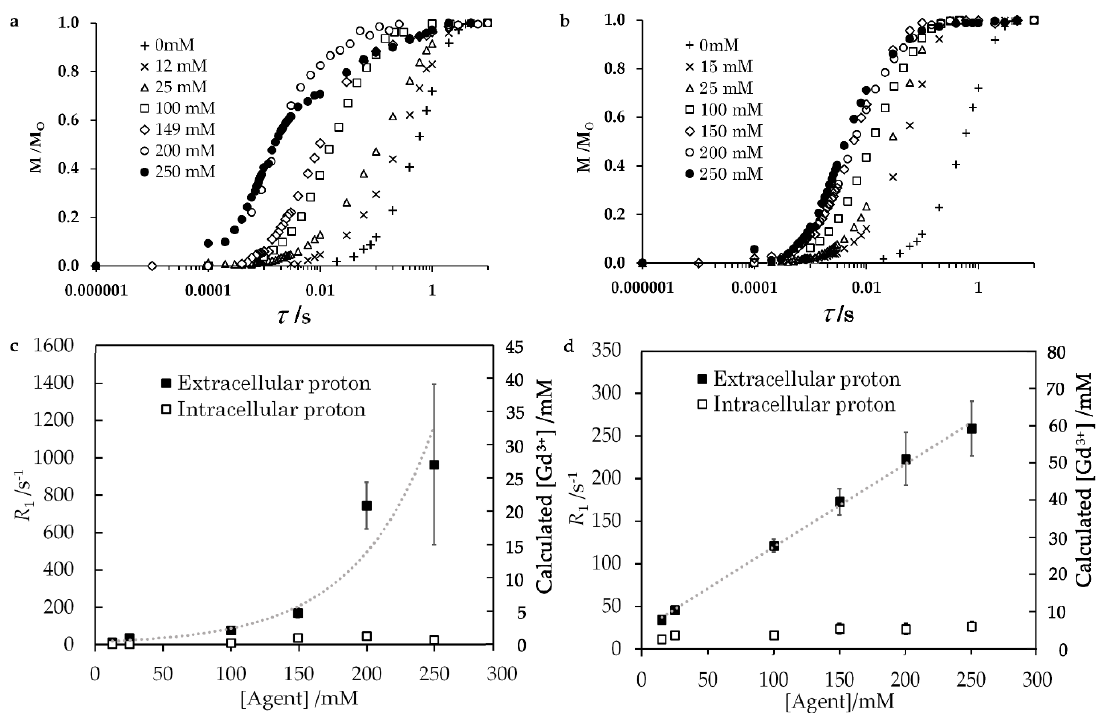
Figure 2. ( a , b ) Relaxation curves of the proton polarization for T 1 , ( c , d ) T 1 relaxation rate and cellular Gd complex concentration estimated from the relaxivities of Gd complex. The samples were 40 µ L of E. coli- glycerol mixtures to which ( a , c ) 10 µ L of aqua Gd 3 + or ( b , d ) Gd-DOTA solutions were added. The left vertical axes on panels c and d are scaled by the relaxivities of Gd complexes for the extracellular water only. Thus, the intracellular T 1 relaxation rate is 73% of the values on these axes. The τ for the horizontal axis ( a , b ) gives the delay after the saturation pulse. Error bars were obtained from the deviation of experimental values from the best fit double exponential functions. Table 1. Intracellular and extracellular T 1 relaxation rates and amplitudes of 40 µ L of glycerol -E. coli - sample to which 10 µ L Gd-DOTA or aqua gadolinium solution was added.